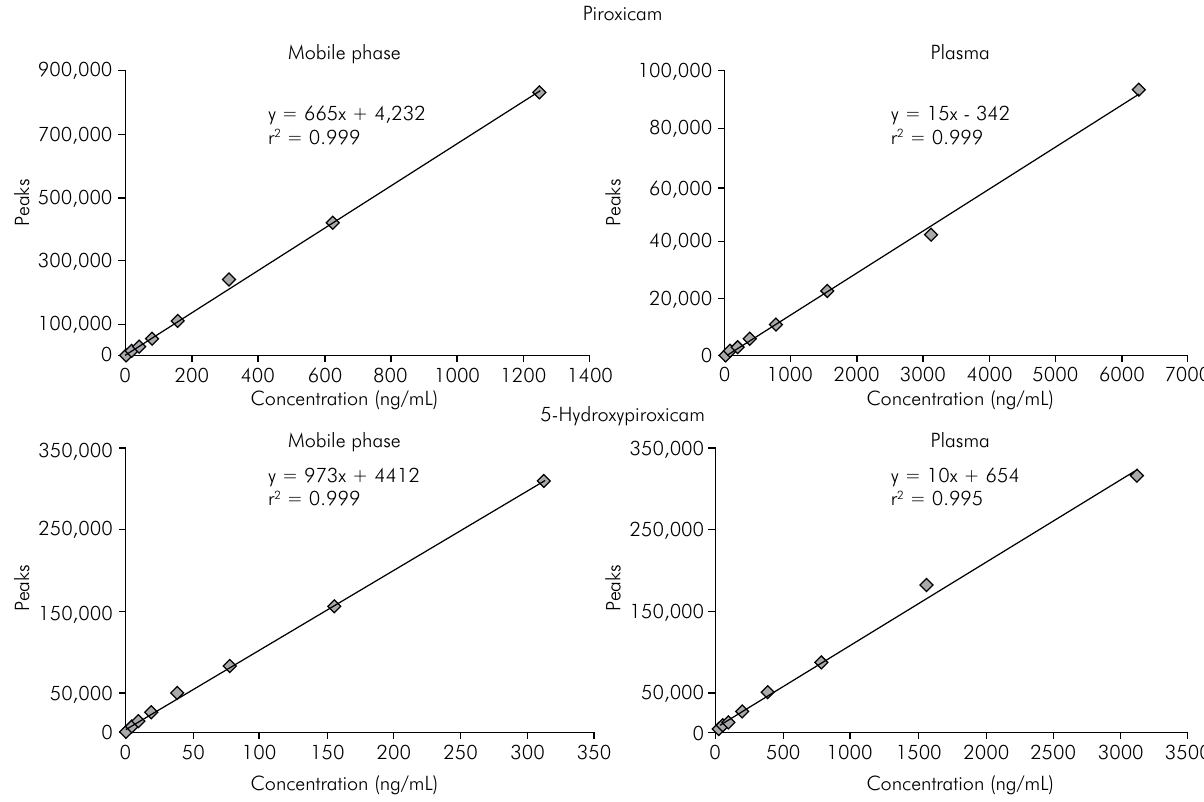
Figure 1. Standard curves of piroxicam and 5-hydroxypiroxicam in mobile phase (left) and in human plasma